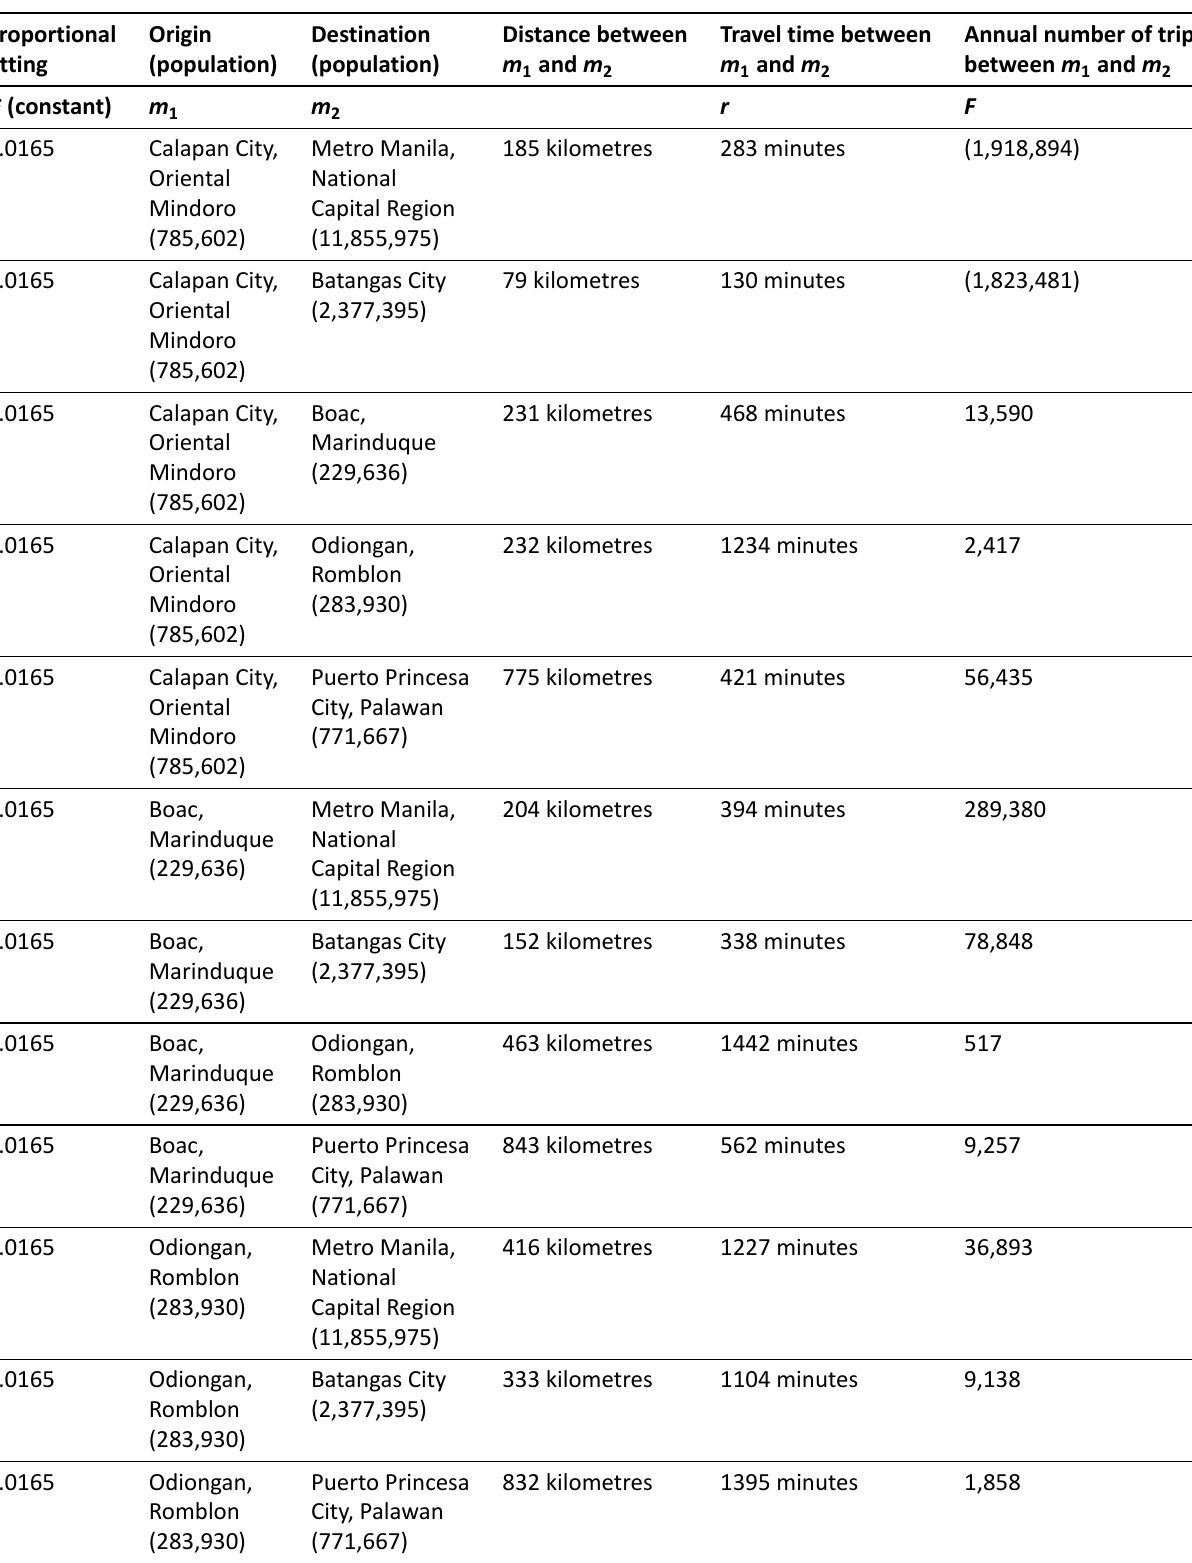
Table 3. Gravity model results for MIMAROPA in